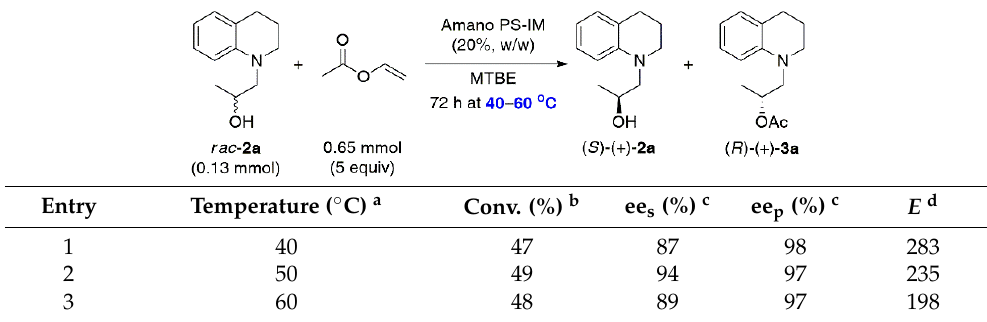
Table 3. Effect of the temperature on Amano PS-IM-catalyzed KR of rac - 2a with vinyl acetate after 72 h.